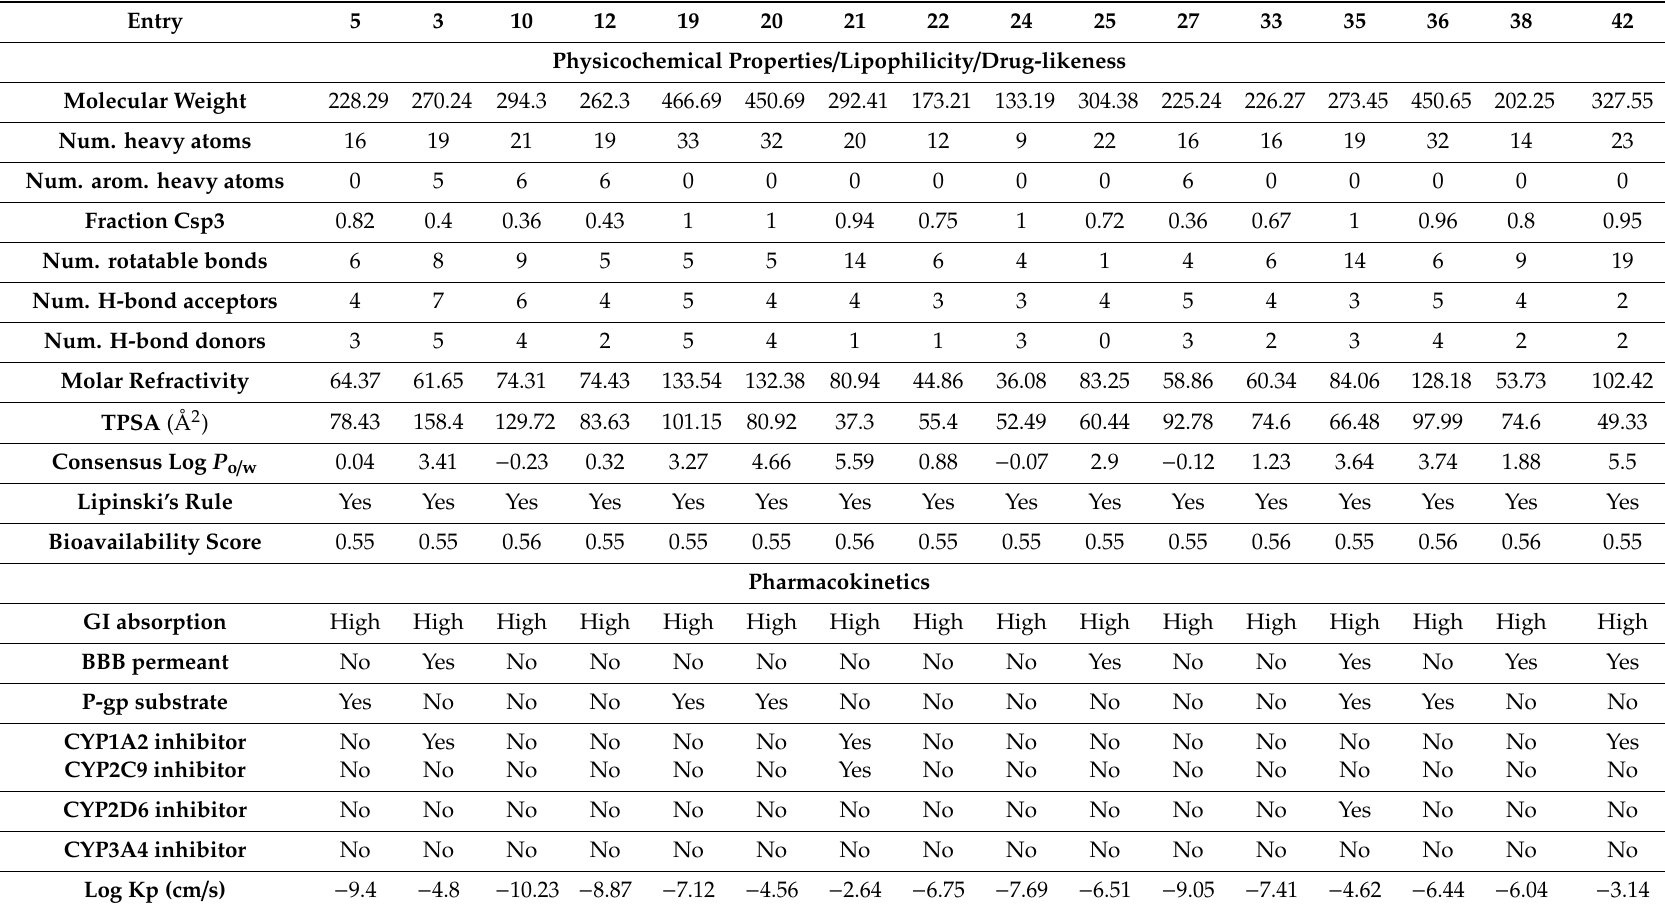
Table 3. Absorption, distribution, metabolism and excretion (ADME) properties of identified